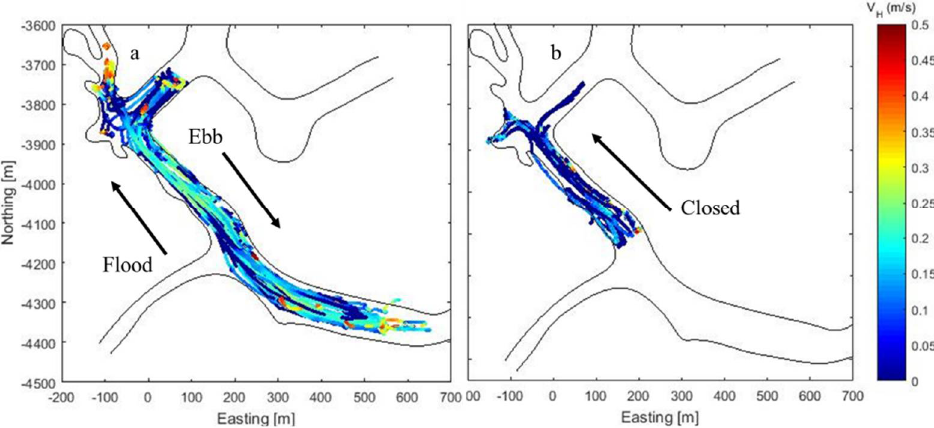
Figure 5. “Spaghetti” plot showing the drifter trajectory coloured by the horizontal velocity magnitude for drifter deployments during study: arrow indicate the main flow direction. ( a ) E1 under open inlet condition, ( b ) E2 under closed inlet condition.